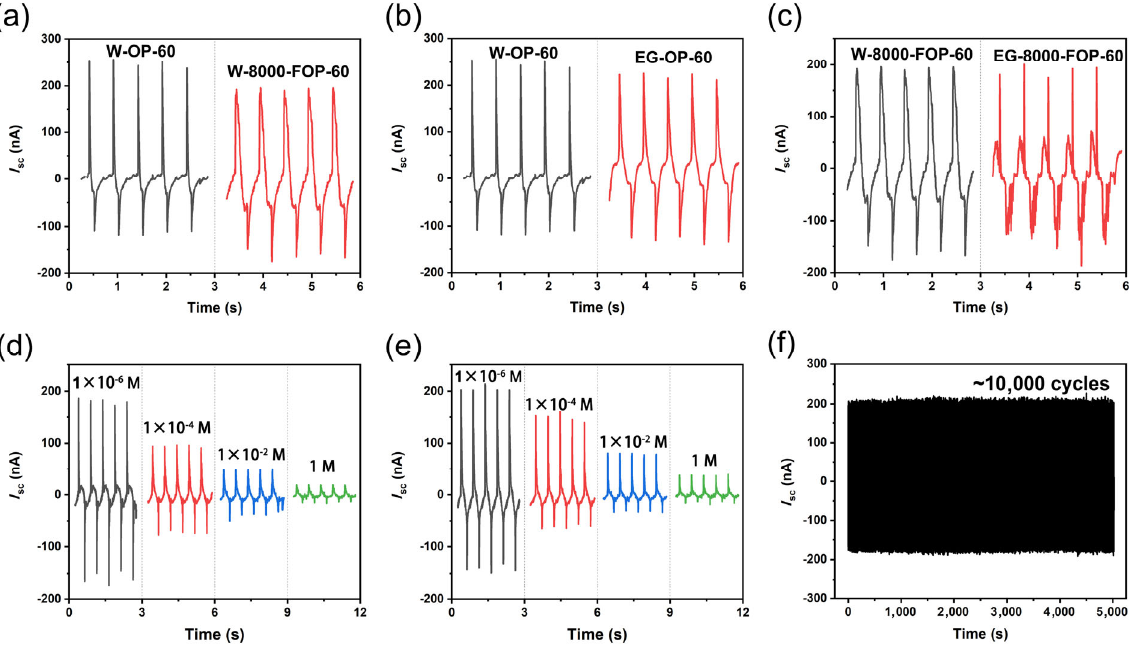
Fig. 5 Triboelectrification behavior of the OP-60 TENG and 8000-FOP-60 SLIPSs TENG. (a) I sc of W-OP-60 TENG and W-8000-FOP-60 SLIPSs TENG. (b) I sc comparisons of the W-OP-60 TENG vs. EG-OP-60 TENG, and (c) the W-8000-FOP-60 SLIPSs TENG vs. EG-8000-FOP-60 SLIPSs TENG. Response of (d) OP-60 TENG and (e) 8000-FOP-60 SLIPSs TENG to NaCl concentrations from 10 –6 to 1 M. (f) Stability test of the W-8000-FOP-60 TENG over about 10,000